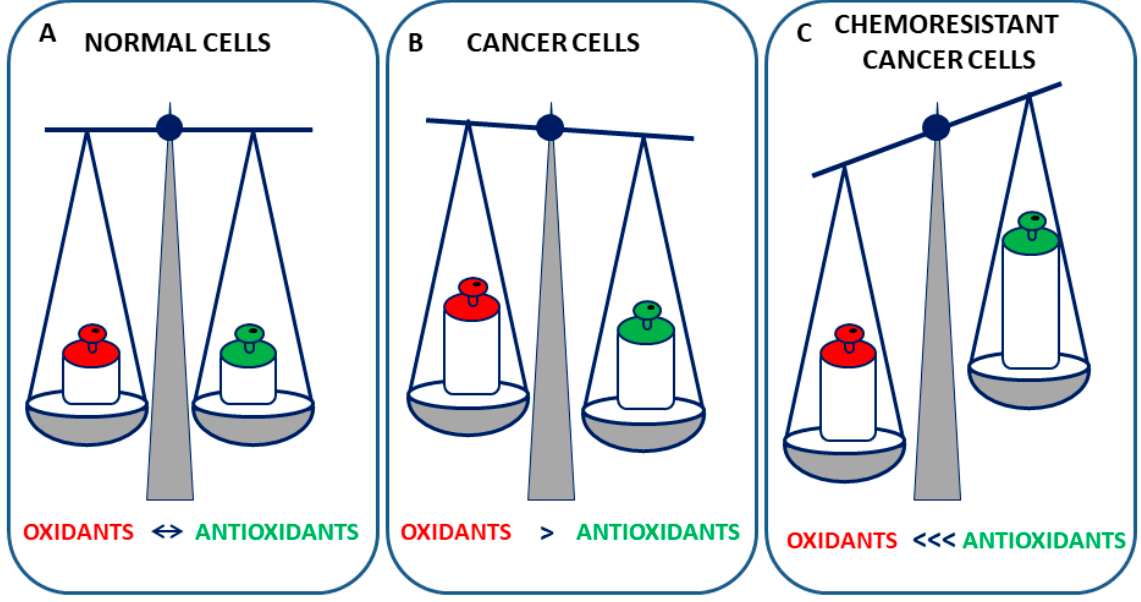
Figure 2. Oxidant and antioxidants in redox homeostasis in normal, cancer, and chemoresistant cancer cells. ( A ) Normal cells keep constant oxidant production and elimination to maintain a favorable redox balance. ( B ) Cancer cells exhibit higher steady-state levels of oxidant species, counterbalanced by increased antioxidant capacity. ( C ) Chemoresistant cancer cells up-regulate the antioxidant defenses to counteract oxidant species.